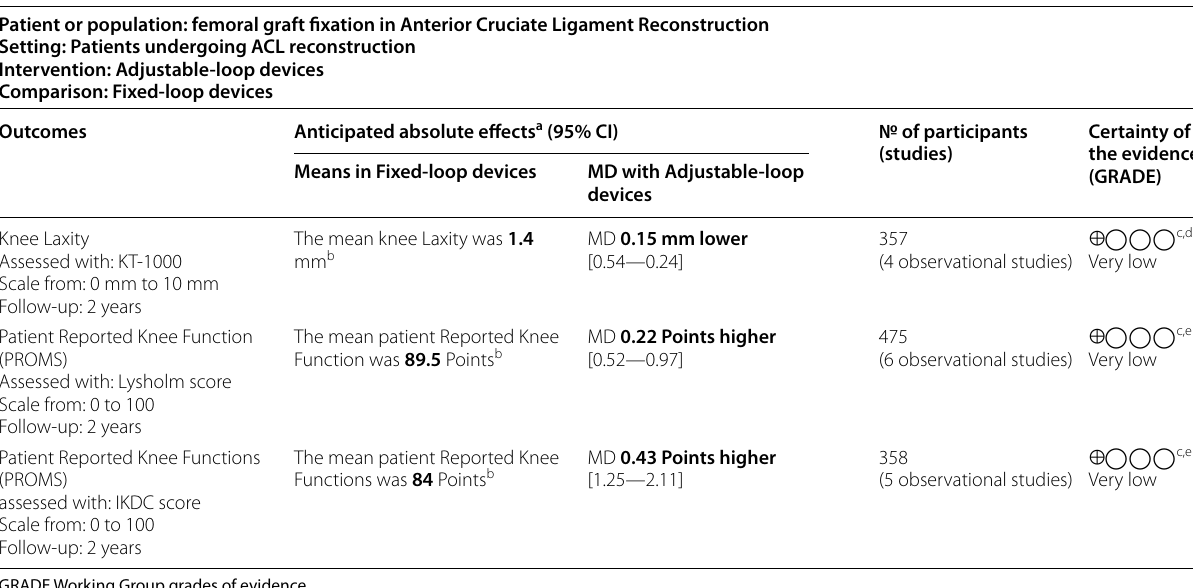
Table 5 Summary of findings